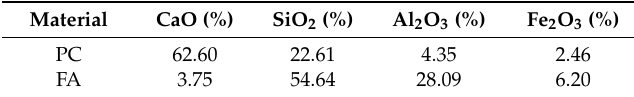
Table 1. Main chemical composition of PC and FA.